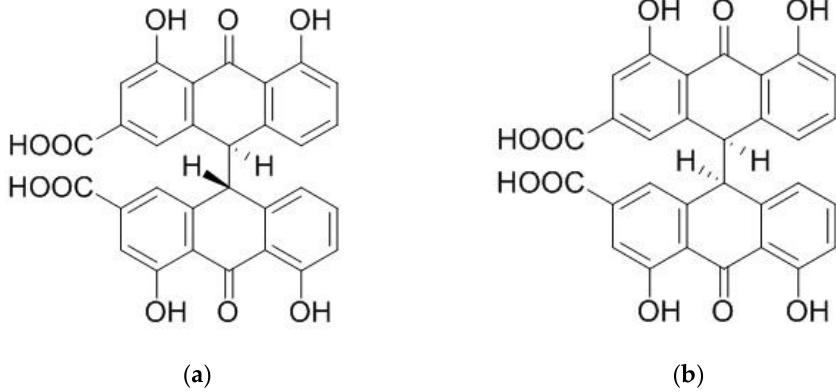
Figure A9. Chemical structure of ( a ) sennidine A and ( b ) sennidine B.